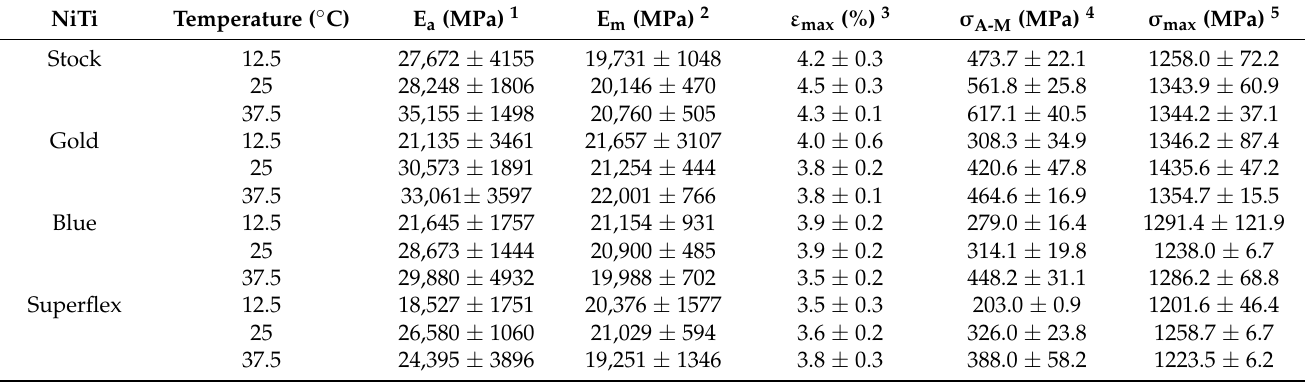
Table 2. Tensile test results for different alloy types at 3 ambient temperatures (outcomes expressed in means ± standard deviation [SD] with n =